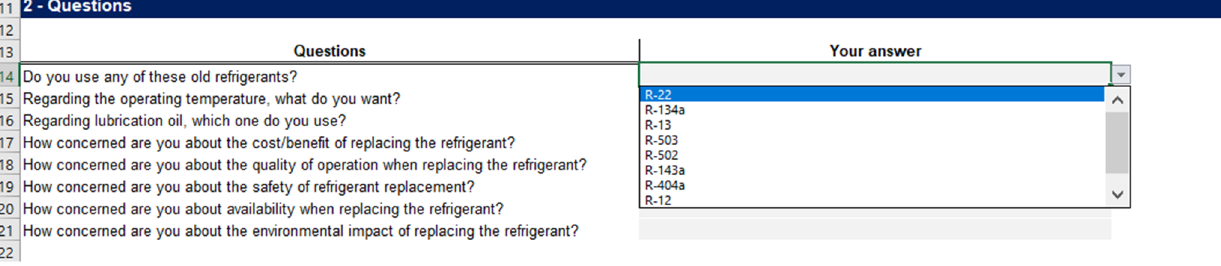
Figure 2. Example of dropdown boxes in the tool.